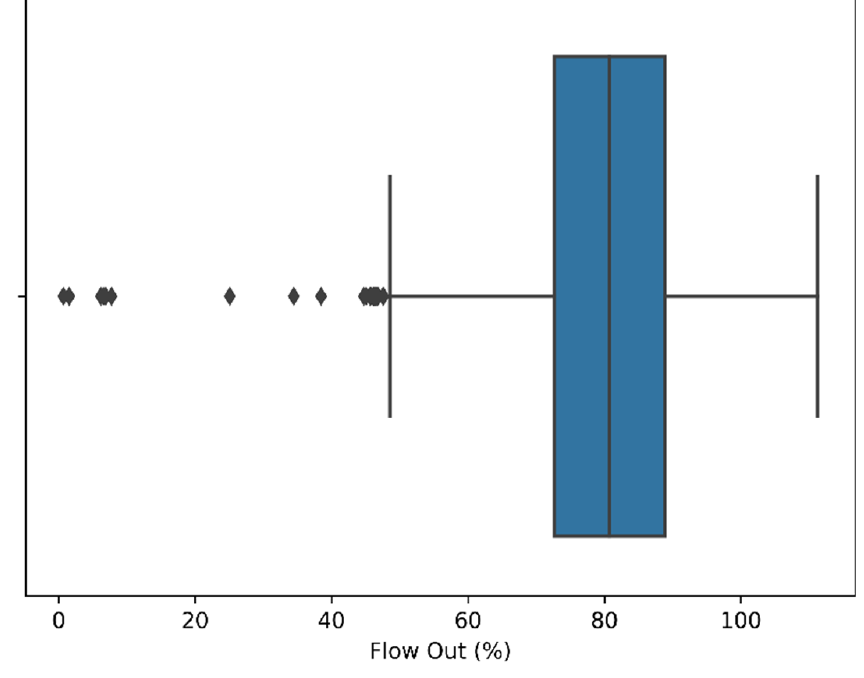
Figure 11. Flow Out boxplot . Figure 11. Flow Out